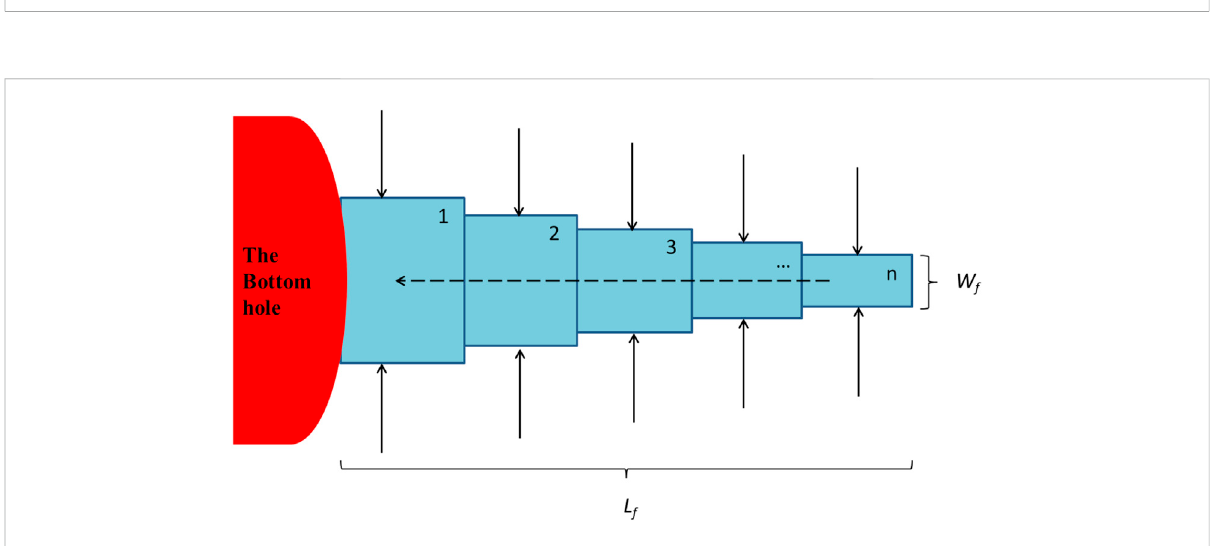
FIGURE 7 Simpli fi ed model of single-slit seepage fl